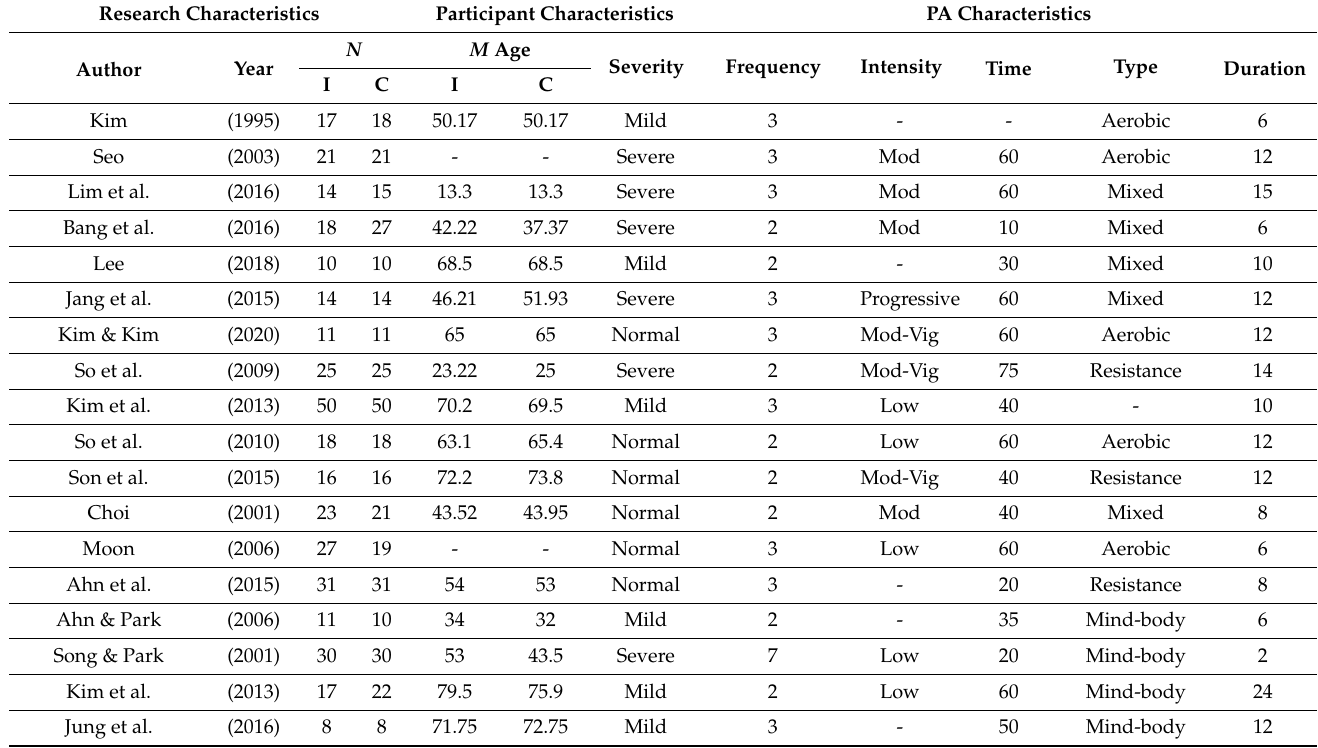
Table 1. Characteristics of the included